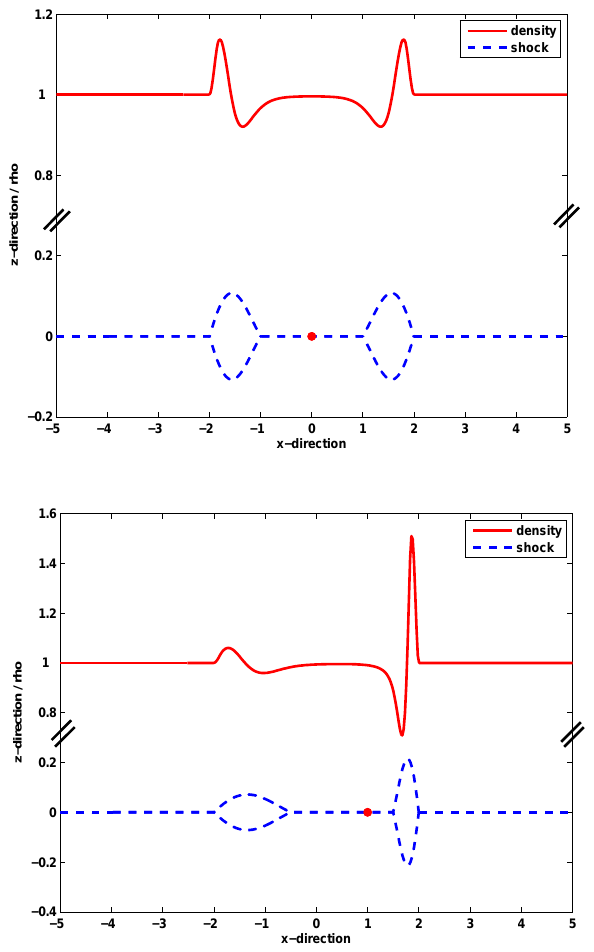
Fig. 10. Density perturbations and corresponding shocks for U = 0 (upper panel) and U = 0 . 5 (lower panel) and z = 0 . 5. The calcula- tions were done for β = 1. The compression factor for the shocks is ρ 0 /ρ FRR = 0 . 7.